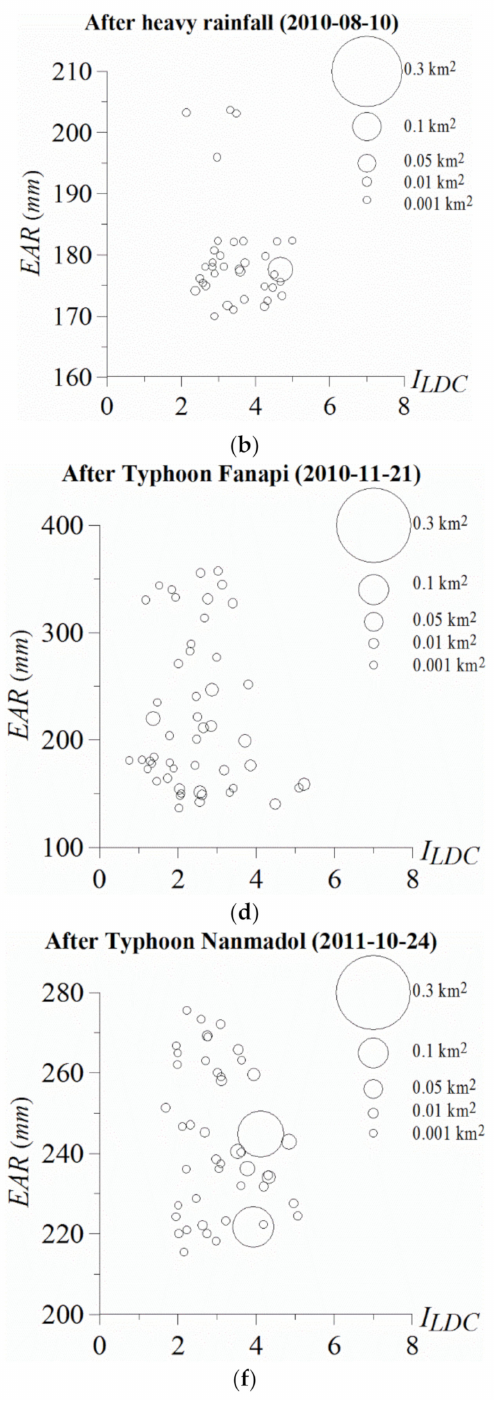
Figure 11. Plot of EAR against I LDC for the second landslide points, with the size of the circle indicating the increment in landslide area, after ( a ) Typhoon Morakot (2009), ( b ) heavy rainfall on 27 July 2010, ( c ) Typhoon Meranti (2010), ( d ) Typhoon Fanapi (2010), ( e ) Typhoon Meari (2011), and ( f ) Typhoon Nanmadol